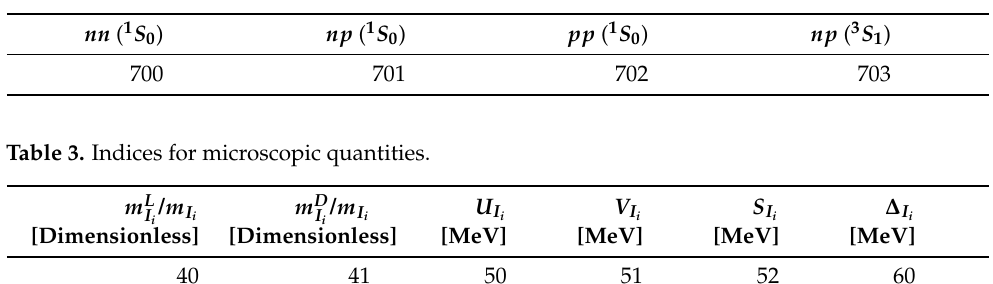
Table 2. Two-body correlation indices (with most relevant channel).